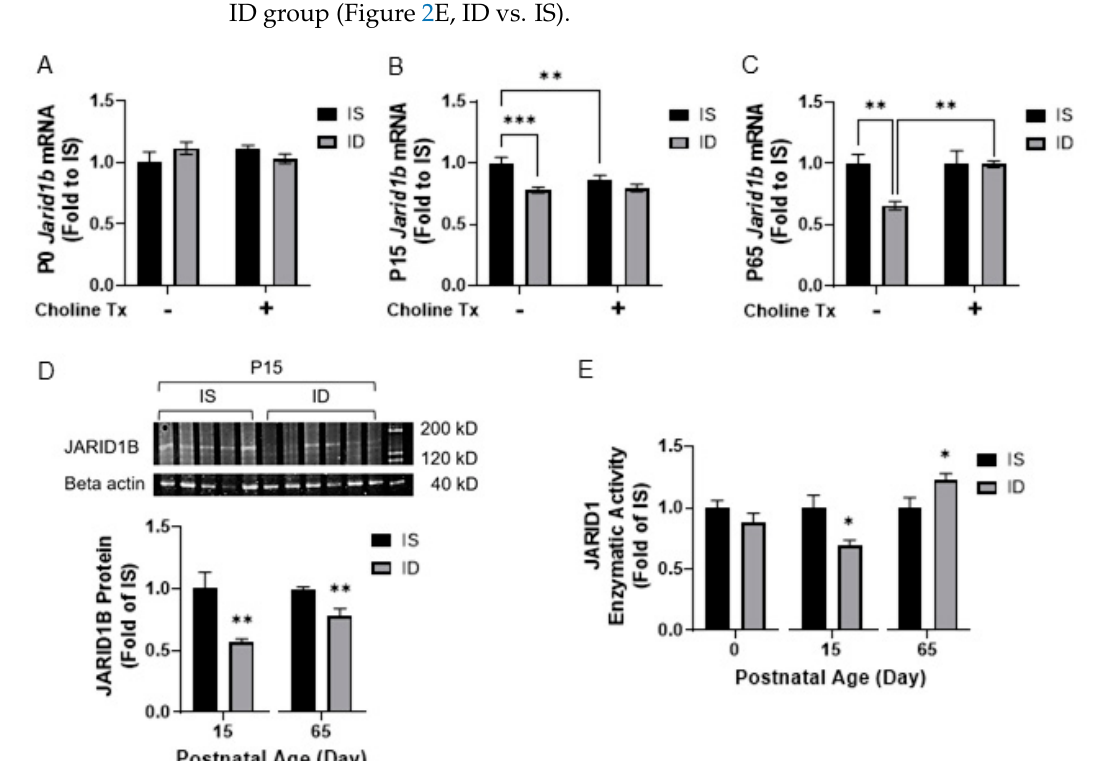
Figure 2. Iron deficiency alters expression and enzymatic activity of hippocampal JARID1 in the ID rats. ( A – C ) Hippocampal Jarid1b RNA expression in IS, ID, ISCh and IDCh groups at P0 ( A ), P15 ( B ) and P65 ( C ) quantified by Real-time quantitative PCR(RT-qPCR). ( D ) Hippocampal JARID1B protein expression in IS and ID groups at P15 and P65 measured with Western blot. Representative Western blot image of JARID1B at P15 is shown. ( E ) Hippocampal JARID1 activity in IS and ID groups at P0, P15 and P65 assessed with enzyme-linked immunosorbent assay. All data were normalized to the age-matched IS group. Tx: Treatment (Supplementation). Values are mean ± SEM; n = 5–6/group; * p < 0.05, ** p < 0.01, *** p <